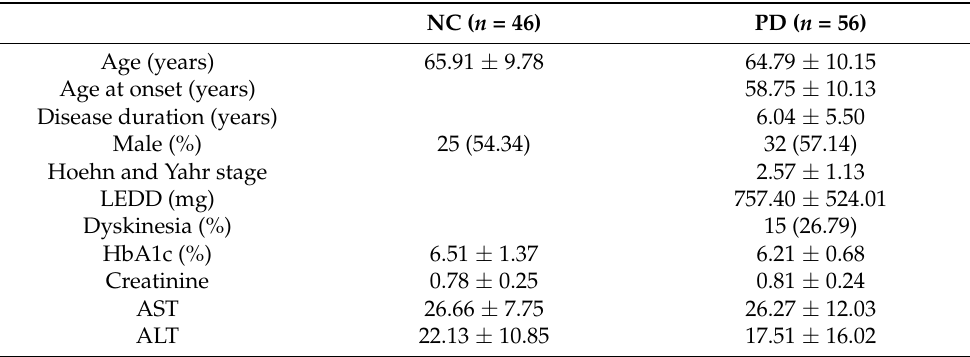
Table 1. Demographic characteristics and blood biochemical parameters of patients with Parkinson’s disease (PD) and normal controls (NC).